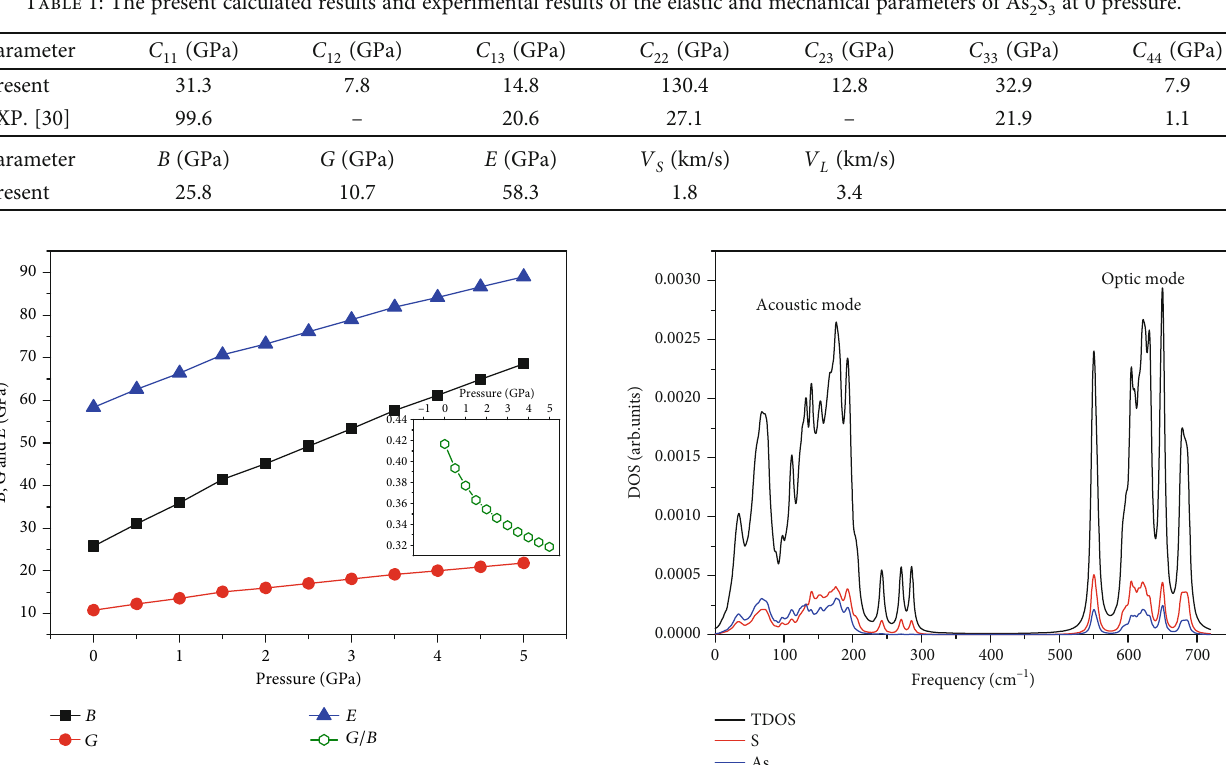
Figure 4: The mechanical moduli of orpiment As The inserted picture shows the Pugh ratio evaluation ( G / B ).